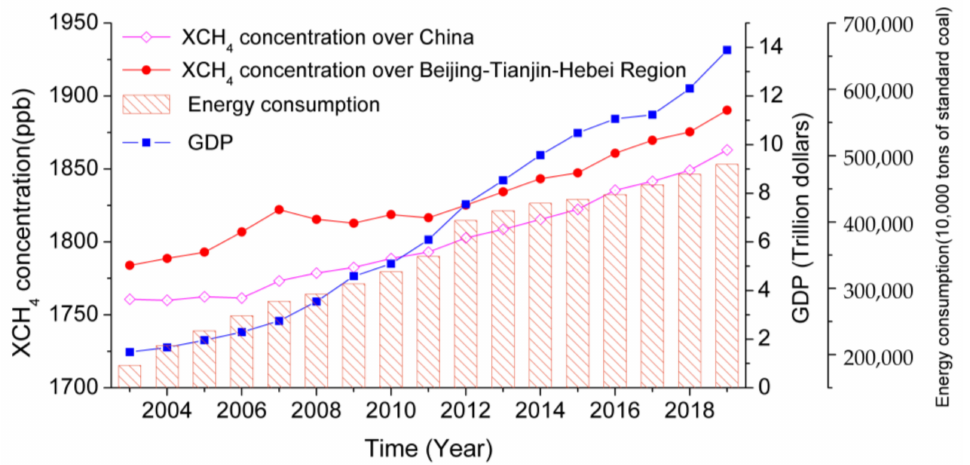
Figure 8. The relationship between XCH 4 concentration and GDP and total energy consumption over China from 2003 to